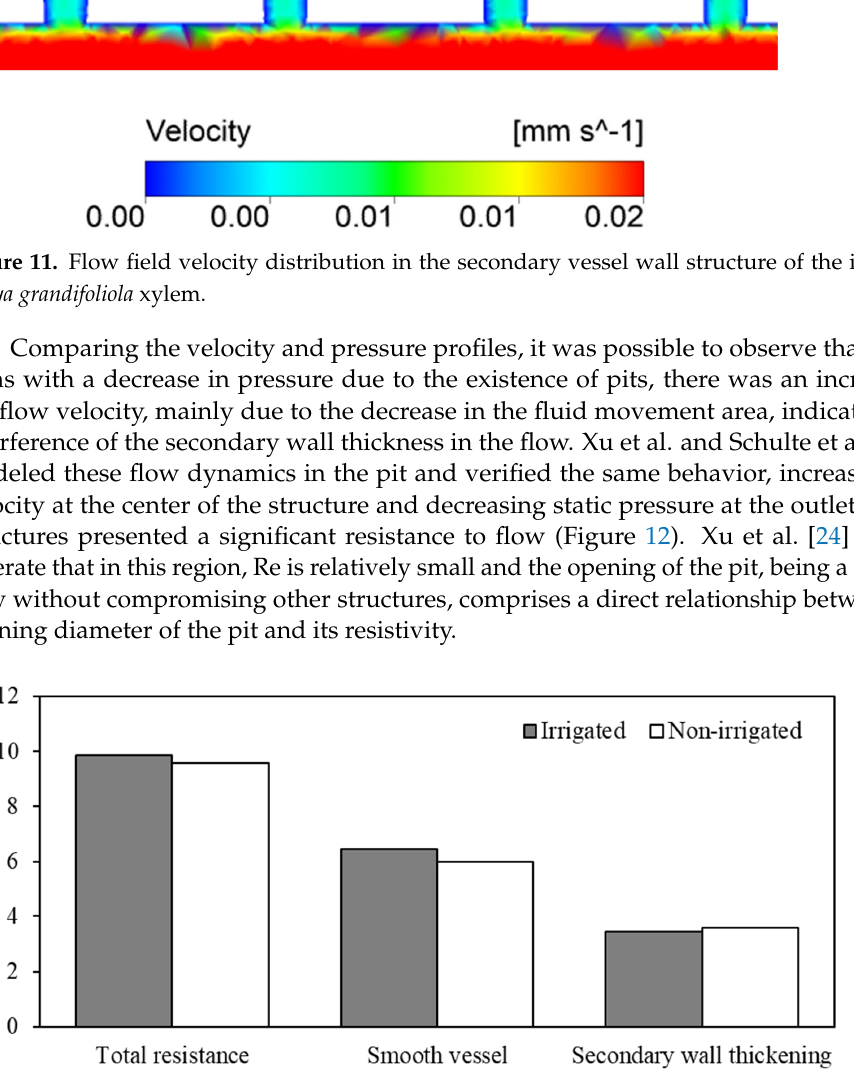
Figure 12. Total and structural component strength of the xylem vessel model in Khaya grandifoliola .